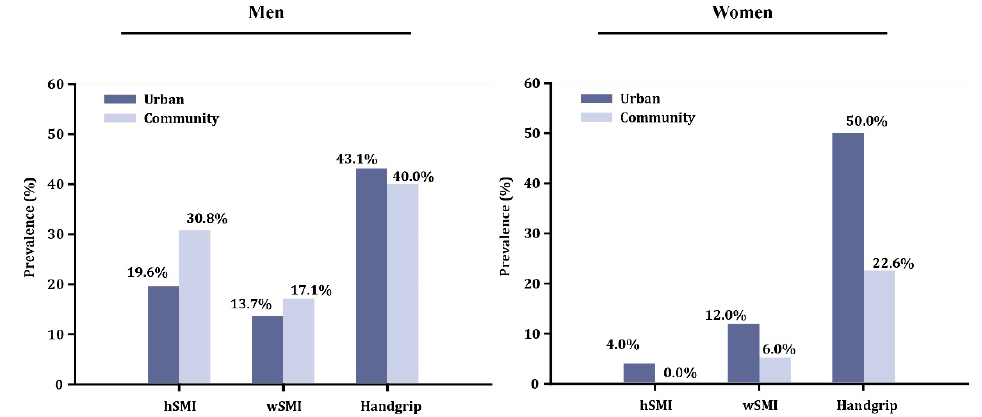
Figure 3. Prevalence of low muscle mass using each of two adjustment indices and of handgrip strength. hSMI: height-adjusted skeletal muscle index; wSMI: weight-adjusted skeletal muscle index.